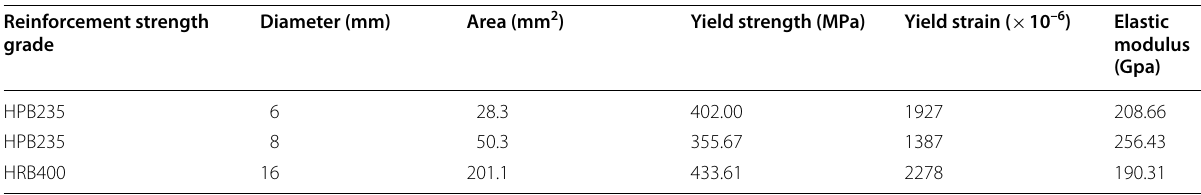
Table 3 Mechanical properties of reinforcement. Reinforcement strength